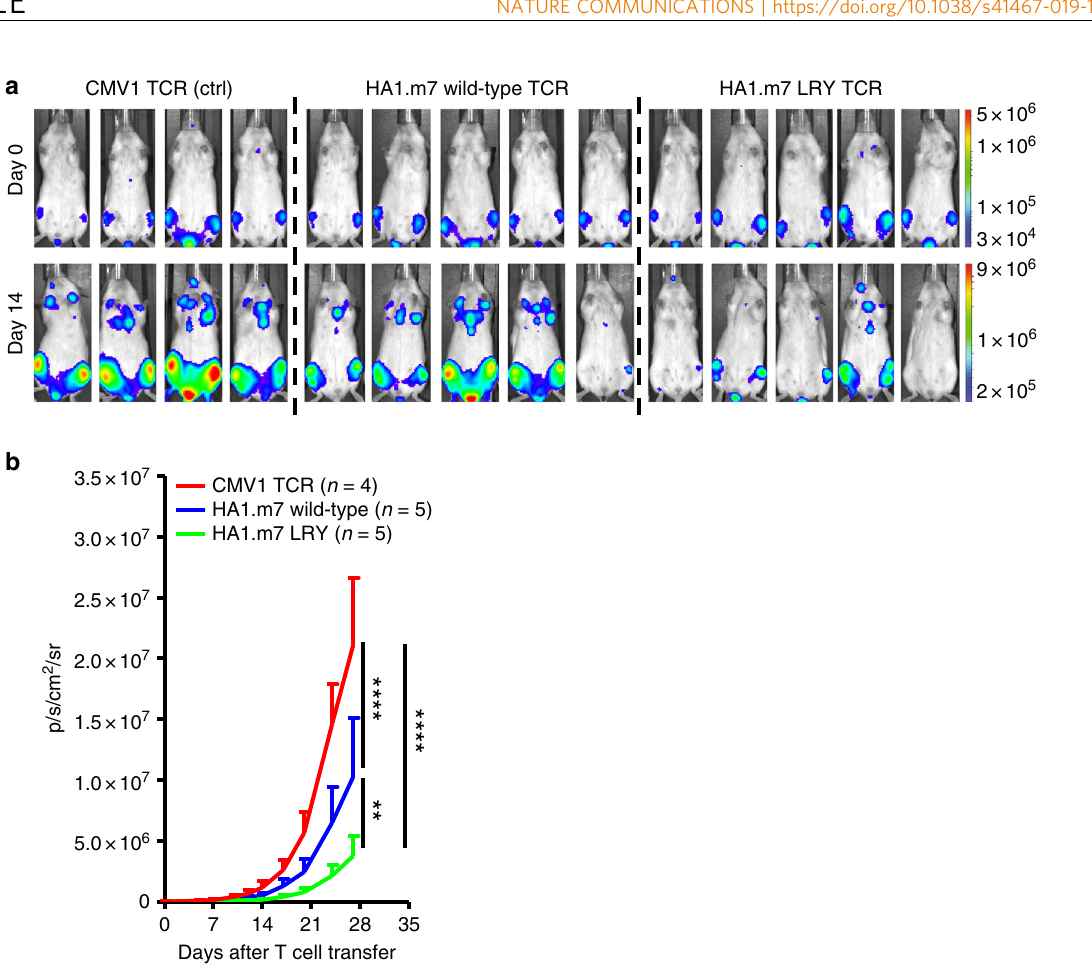
Fig. 8 Residues L96 α , R9 β , and Y10 β improve tumor control in vivo. NSG mice were injected i.v. with 2 × 10 6 HLA-A*0201 + U266 multiple myeloma cells, which naturally express HA1. These cells were transduced with luciferase to enable bioluminescent imaging of the resulting tumors. a Top panel: all mice displayed similar tumor burdens after 10 days (day 0 of treatment). Mice were then injected i.v. with 3 × 10 6 human CD19 + CD8 + T cells expressing either the control (ctrl) CMV1 TCR ( n = 4), the wild-type HA1.m7 WT TCR ( n = 5) or the LRY-modi fi ed HA1.m7 TCR ( n = 5). Bottom panel: mice injected with the LRY-modi fi ed HA1.m7 TCR showed the lowest tumor burdens on day 14 of treatment. b Pooled summary data (means ± SEM) of bioluminescent imaging performed at the indicated time points over a period of 28 days. Signi fi cance was determined using a two-way ANOVA with Tukey ’ s